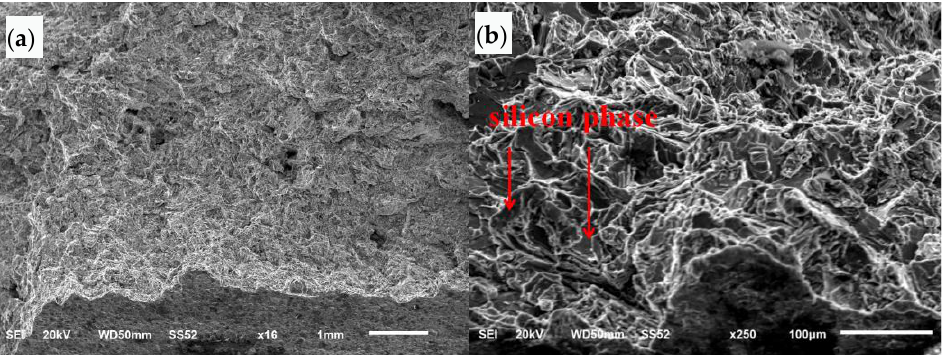
Figure 10. SEM morphology of the fracture initiation zone of the hinged plate: ( a ) low magnifica- tion, ( b ) high magnification.